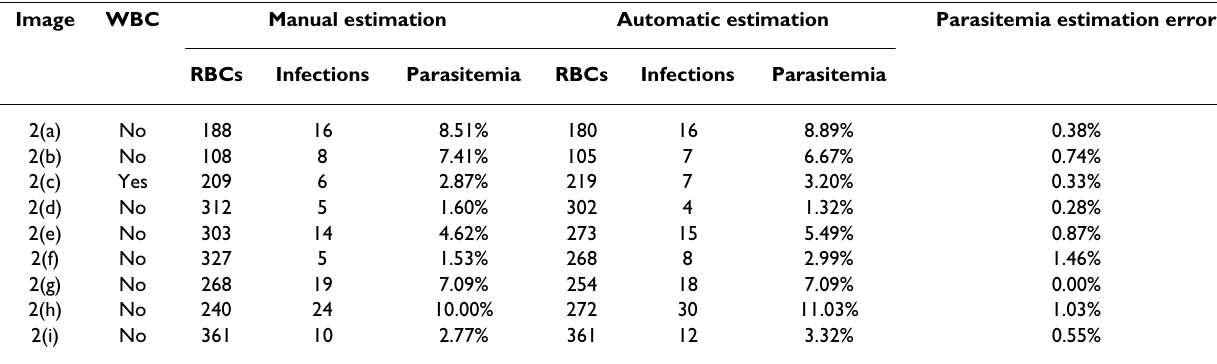
Table 1: Comparison of manual and automatic parasitemia estimation Image WBC